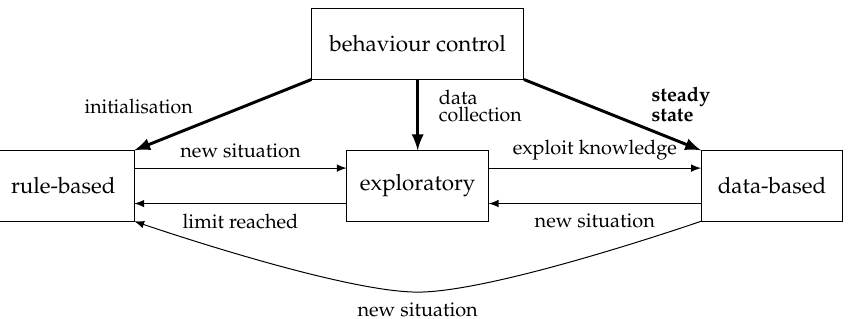
Figure 2. A general representation of the concept. The overarching behaviour control unit oversees the incoming reactions from the user. In conjunction with the information level of the system, the unit chooses the most appropriate behaviour. The main situations occurring are the first initialisation, the need for data collection and the final learned reactions specific for the user standby state. As can be seen, new situations tend towards the exploratory state, except when the interaction between system and user breaks